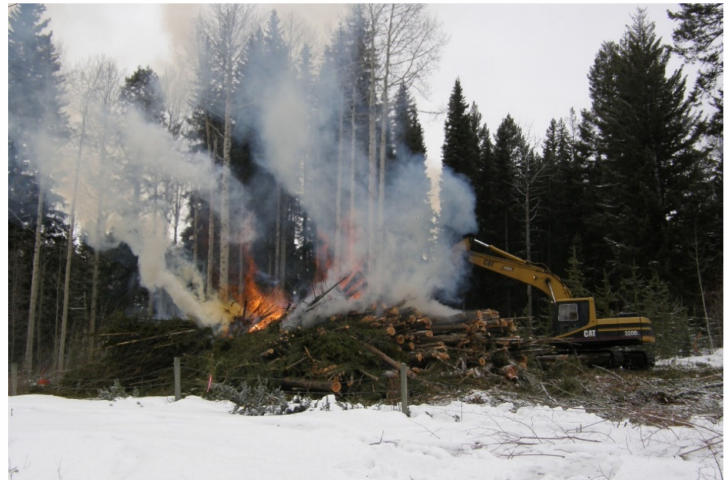
Figure 1. Burning of debris pile.